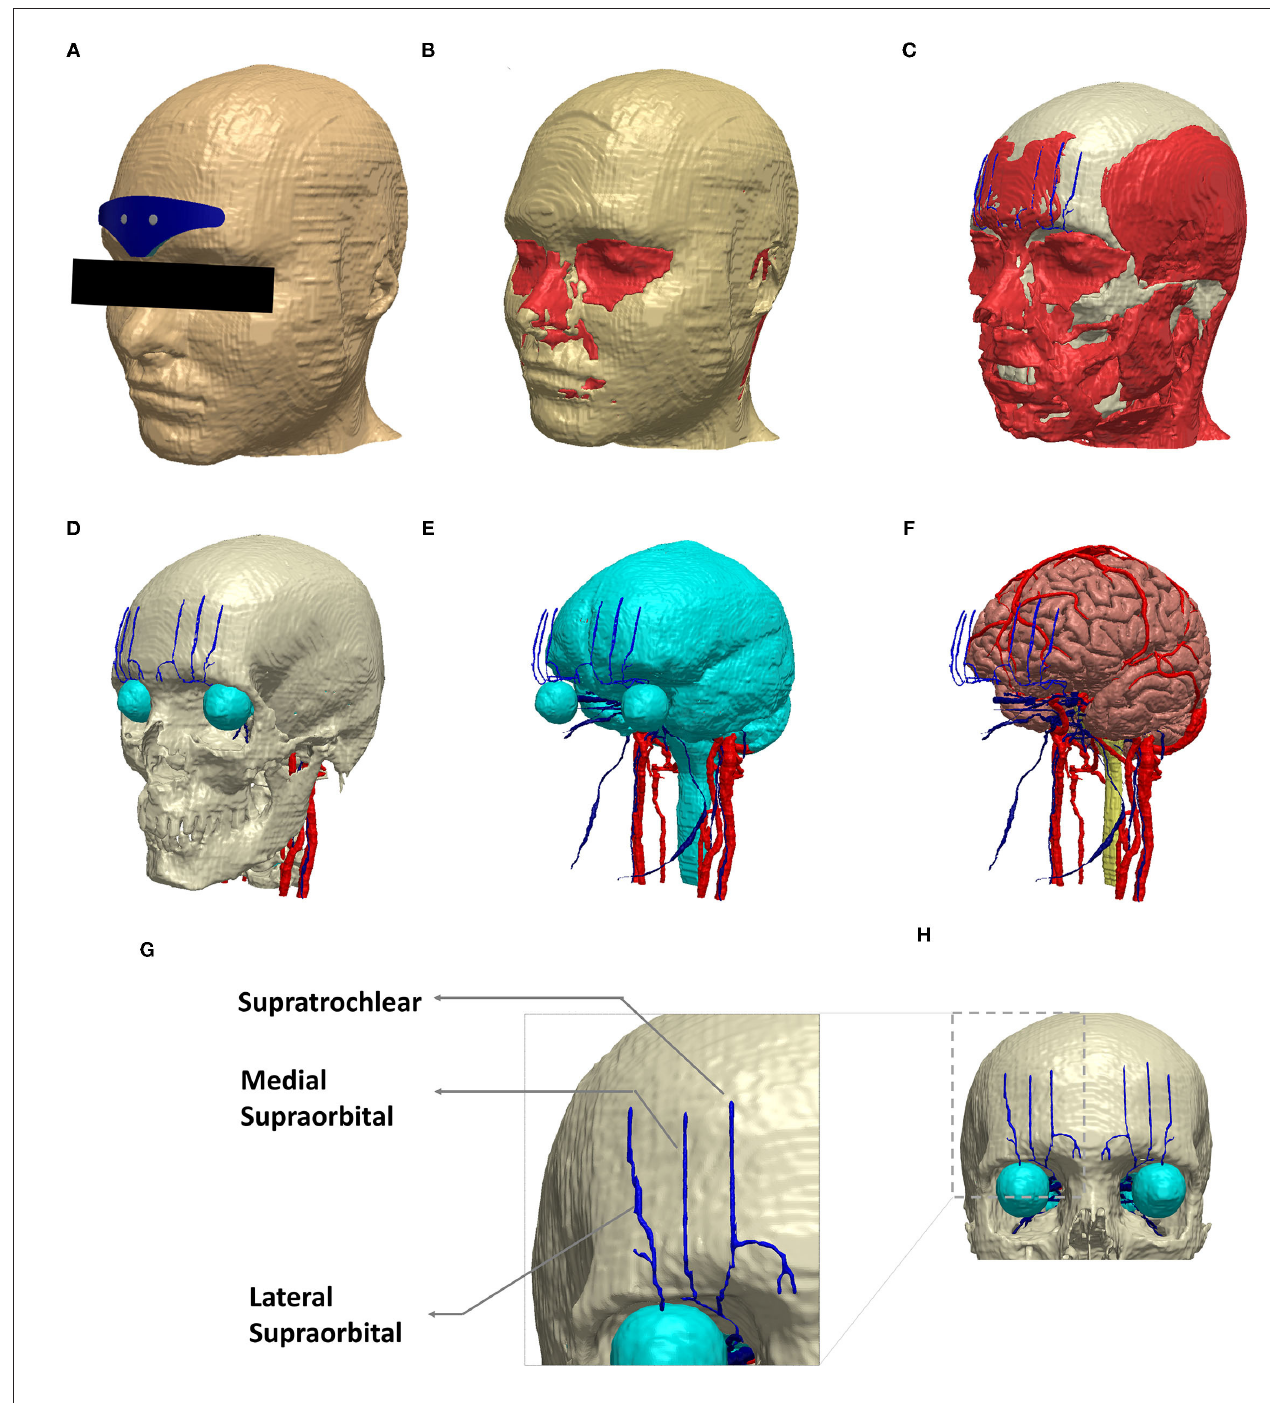
FIGURE 2 | Schematic view of the implemented model geometry. Exemplary segmentation masks are shown: (A) scalp and the V-shaped geometry, (B) fat and muscle in red, (C) muscle along with skull (white), (D) skull and the target trigeminal nerves (blue). The eye region (part of CSF mask) and other cranial nerves (red) visible at the skull level are all shown. (E) CSF along with trigeminal and other cranial nerves. (F) gray matter, trigeminal nerves, and other cranial nerves. (G) The dashed section in (H) is expanded to highlight the trigeminal nerve geometry incorporated in the model. (A–F) were generated in the same perspective.